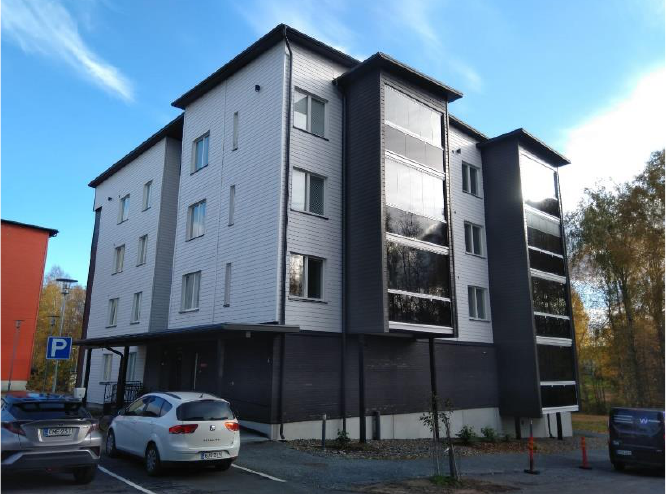
Figure 8. As Oy Tampereen Härmälänsydän — Tarmonkuja 4, Härmälä (photo courtesy of Suomen metsäkeskus).